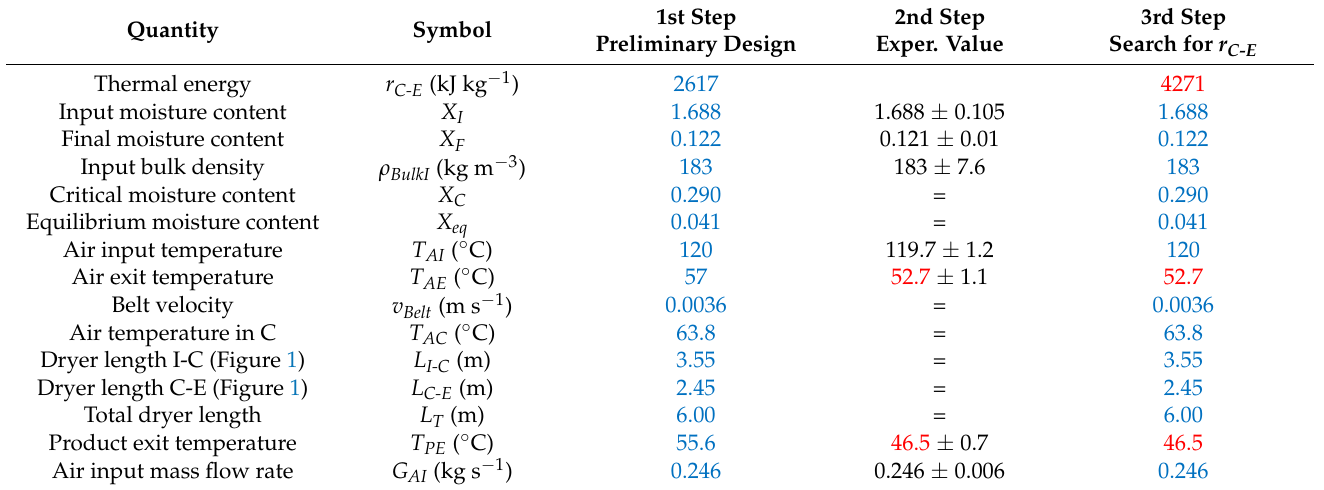
Table 3. Results of the three steps to obtain the thermal energy r C-E concerning the humidity X < X C . The first step refers to the results of the preliminary design with r C-E equal to r I-C = 2617 kJ/kg. The second step concerns the experimental measurement of moisture content and temperatures of the air and of the product (red font). The third step concerns the r C-E value found (red font) through the equations of the design guidelines 2.3 by imposing the experimental temperatures (red